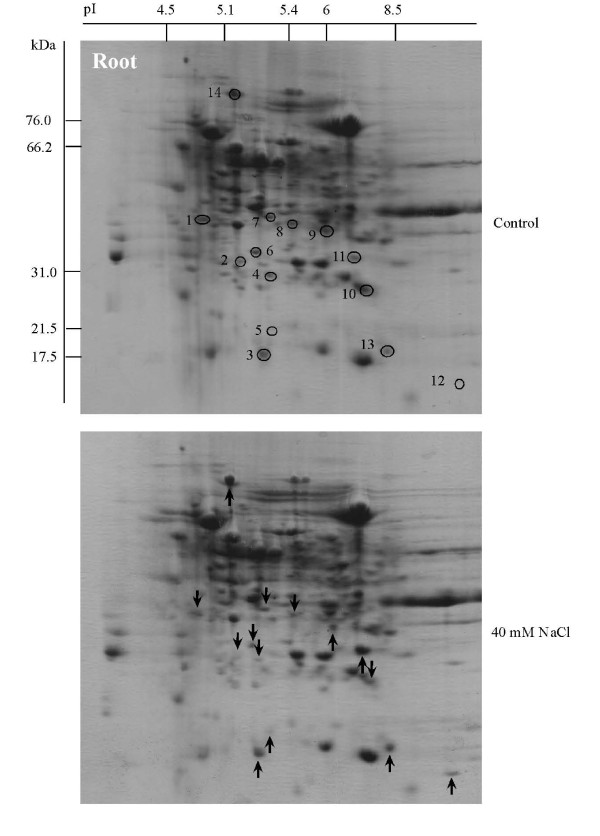
Protein expression patterns in the root of soybeans treated with NaCl. Seeds were sown and treated with 40 mM NaCl. After 7 days, proteins were extracted from the root separated by 2-DE, and visualized by CBB staining. The pI and Mr of each protein were determined using 2-DE markers (Bio-Rad). Arrows indicate protein changes due to NaCl treatment, and circles mark the position of the same proteins from the control. Upward arrows indicate up-regulation and downward arrows indicate down-regulation.